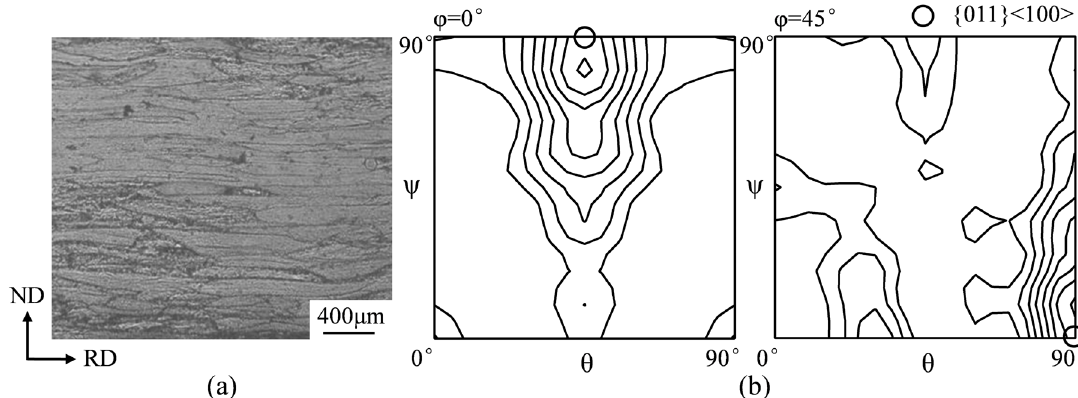
Figure 1. (a) Microstructure and (b) constant φ = 0° and 45° sections of ODFs (levels: 1, 2, 3...) of Fe-4.5 wt.% Si hot bands.